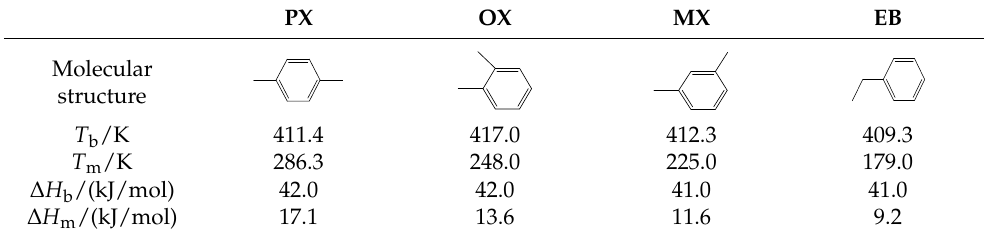
Table 1. The thermodynamic properties of C8 isomers from NIST.